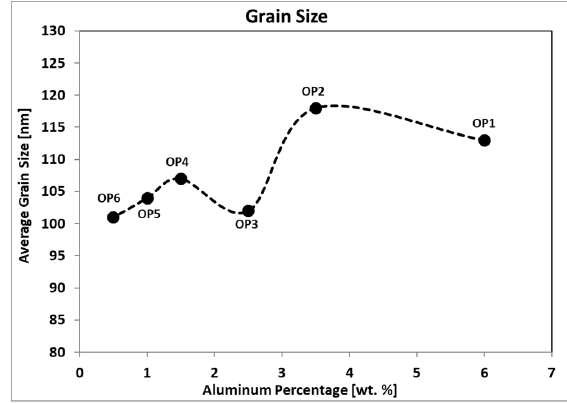
Figure 3. Average grain size of all oxide precipitation hardened (OPH) variants.